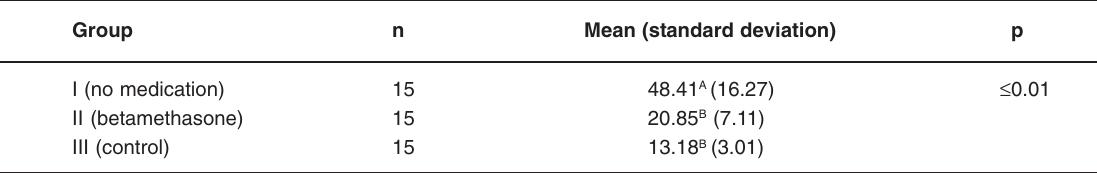
Means followed by same letter do not differ significantly. TABLE 2- Percentage of vascular pulp area in relation to the total pulp area recorded in the